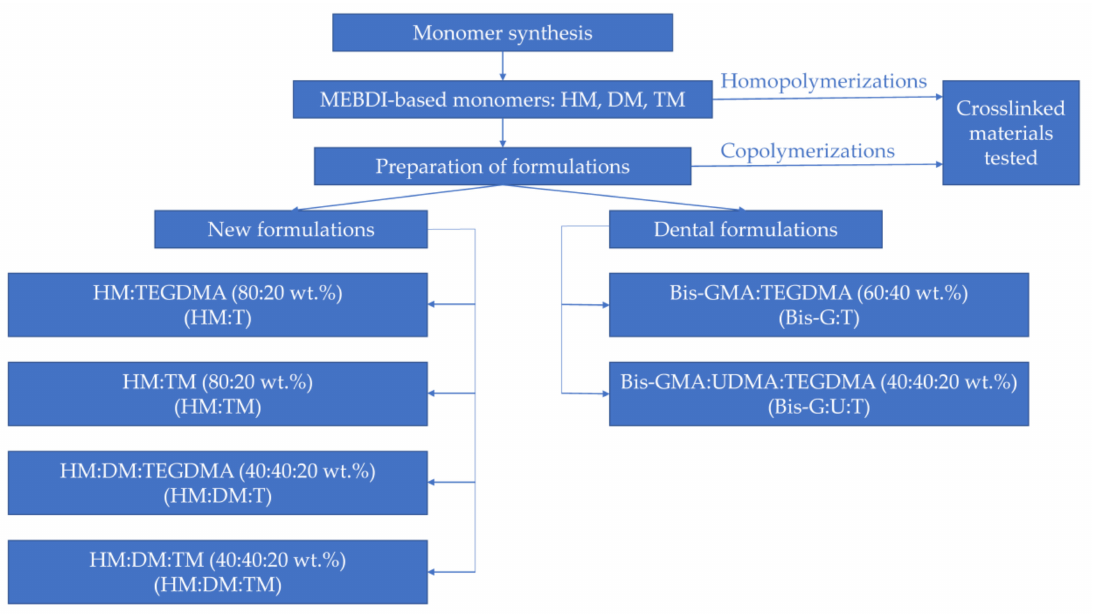
Figure 2. Schematic representation of sample groups tested in this